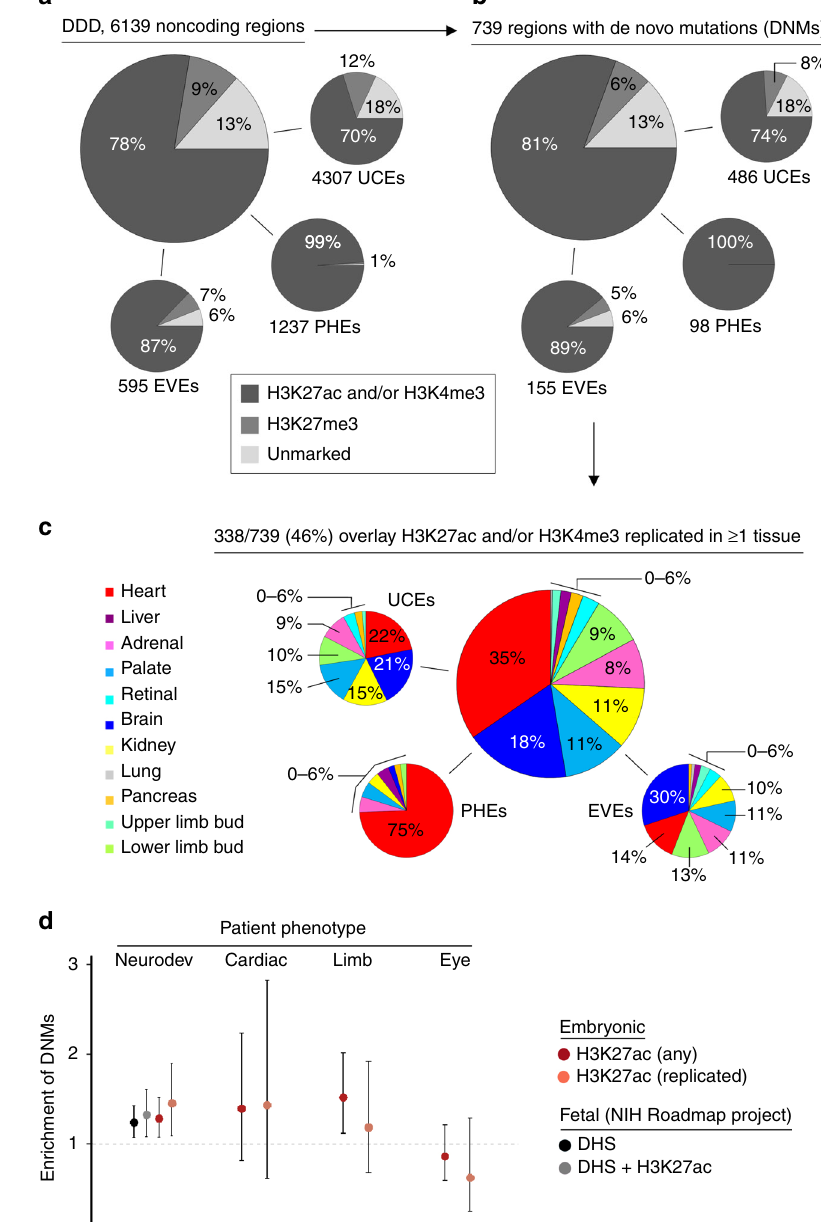
Fig. 6 Overlay of non-coding de novo mutations linked to developmental disorders. a The Deciphering Developmental Disorders (DDD) study included 6139 non-coding regions in its sequence analysis of trios comprising affected individuals and unaffected parents 2,32 . These non-coding regions were selected on the basis of high sequence conservation (ultra-conserved elements, UCEs, n = 4307), experimental validation (experimentally validated enhancers, EVEs, n = 595) or identi fi cation as a putative heart enhancer (PHE, n = 1237). Overlap with any H3K27ac, H3K4me3 or H3K27me3 1 kb bins is shown as an aggregate and for each individual category (UCE, EVE or PHE). b Equivalent overlap is shown for the 739 regions in which disease-associated de novo mutations (DNMs) were identi fi ed. c In total, 46% of DNM-positive regions were situated ( + / − 1 kb) in at least one tissue-replicated H3K27ac and/or H3K4me3 bin. Over half of the disease-associated overlap was covered by the heart/LV (35%) and brain (18%). 75% of the disease-associated PHE regions were situated within 1 kb of a heart/LV-speci fi c histone mark. d Enrichment in the number of DNMs overlapping ( + / − 1 kb) H3K27ac marks during human organogenesis for individuals with neurodevelopmental ( n = 671 cases), cardiac ( n = 124 cases), limb ( n = 312 cases) and eye ( n = 288 cases) phenotypes. The circles represent the observed/expected ratio with asymmetrical error bars showing the 95% con fi dence limits calculated for a Poisson distribution (http://ms.mcmaster.ca/peter/s743/poissonalpha.html). For the neurodevelopmental phenotypes, this included analysis against DNAse hypersensitivity data and H3K27ac data from second trimester fetal brain 10